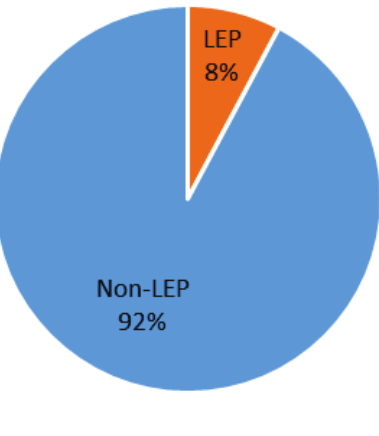
Figure 1: Percentage of Medicare Beneficiaries with and without limited English